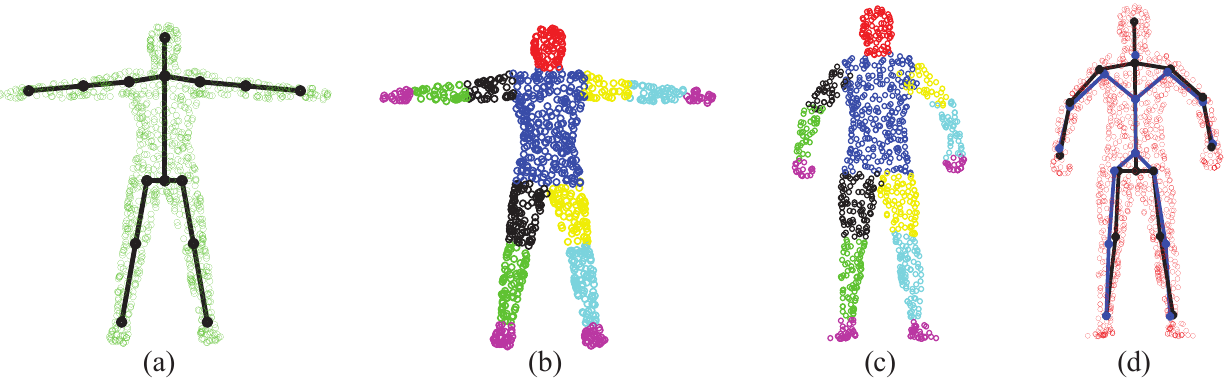
Figure 9. ( a ) The “T-pose” template model used for the SCAPE dataset; ( b ) The labeled template; ( c ) The labeled initial pose; ( d ) The learned subject-specific articulated model for SCAPE data (the estimated skeleton in black and the ground-truth one in blue).